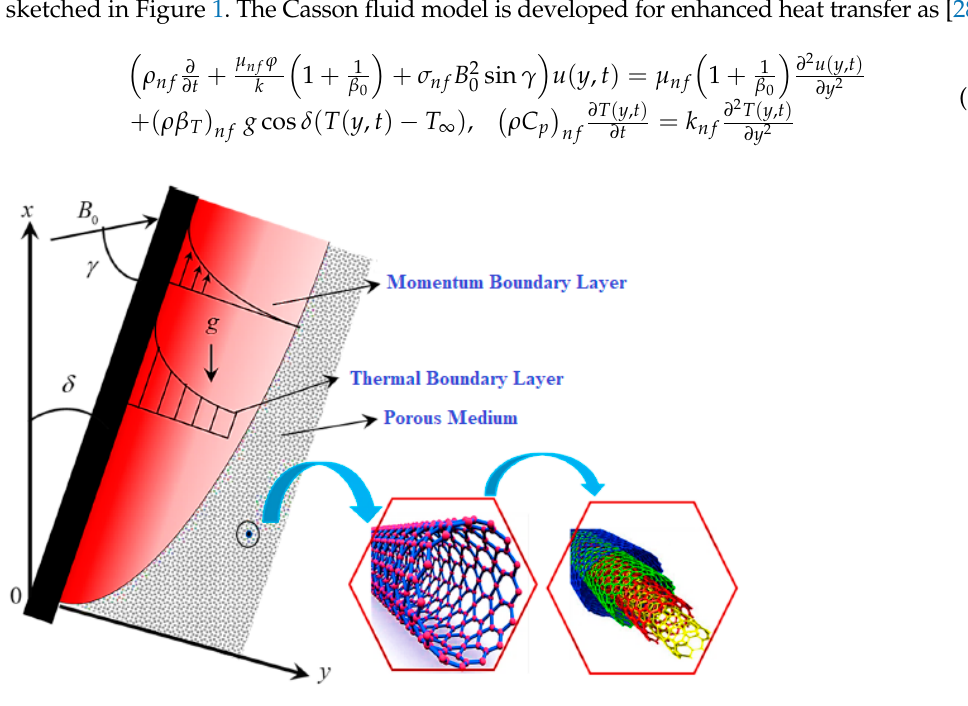
Figure 1. Schematic view of the physical setup.